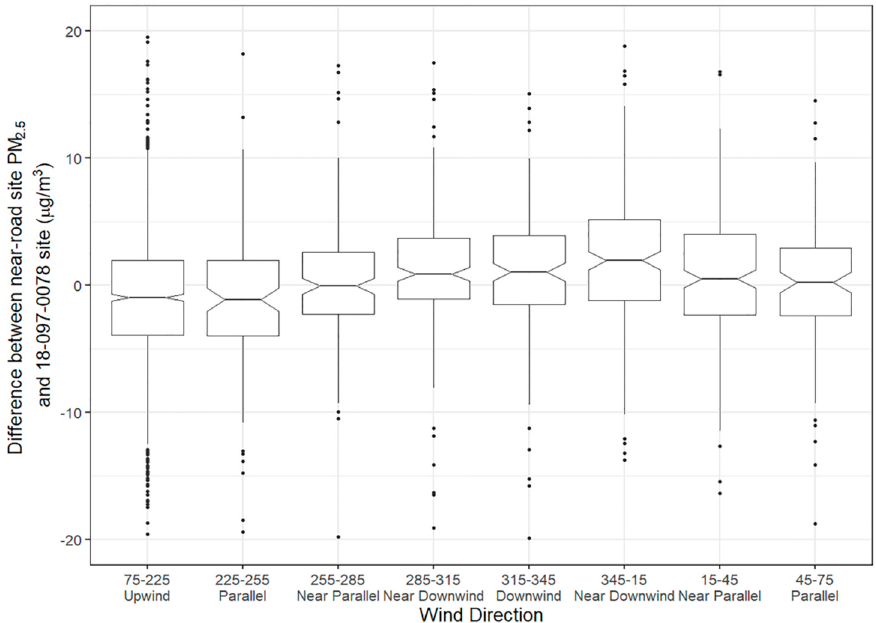
Figure 9. Notched box plot of Indianapolis hourly PM 2.5 increment (difference between near-road and Washington Park site) by wind direction bin during 06:00 to 20:00 and when winds speeds are below 2 m/s. The notch shows the 95% confidence interval on the median and the boxes show the interquartile range (IQR); points beyond the IQR are within the notch or are plotted individually.